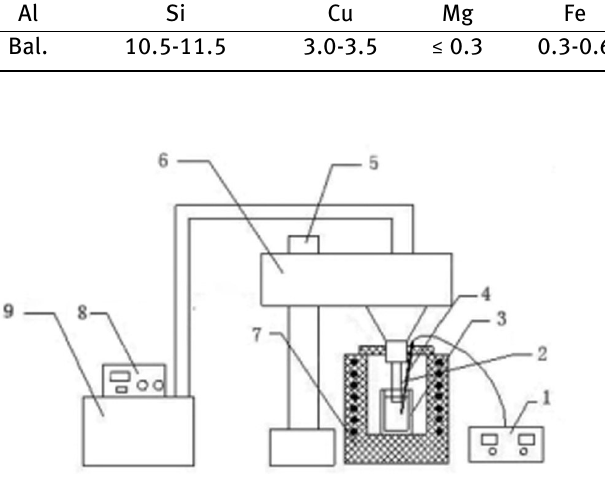
obtain Al Ti. One way is adding Ti powder into Al melt [20, 3 21], Another is adding K TiF powderinto Al melt [22]. The 2 6 first one required higher tempertature and longger time.